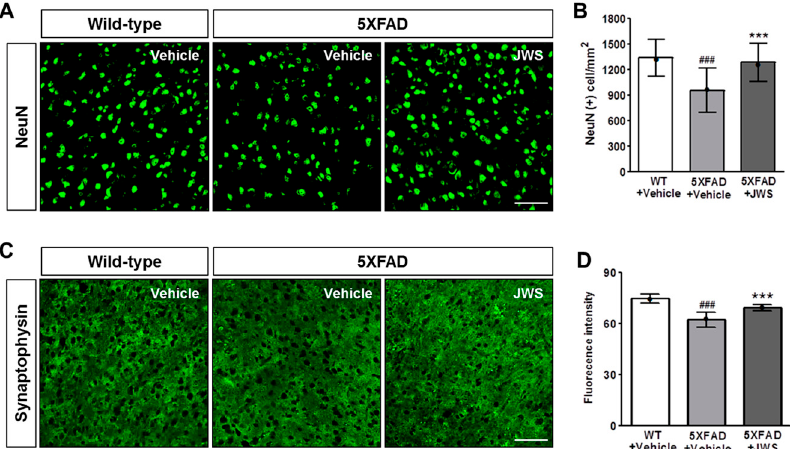
Figure 4. Immunofluorescence evidence of decreased neurodegeneration in the deep cortical layers of the brain in 5XFAD mice. Representative images of brain sections immunostained with anti-NeuN antibody ( A ) and anti-synaptophysin (SYN) antibody ( C ). Scale bar = 100 µ m. Jowiseungchungtang (JWS) significantly reduced the NeuN (+) area ( B ) and SYN (+) area ( D ). Data are presented as mean ± SD ( n = 5 in each group). Significance by Tukey’s post hoc test following one-way ANOVA is indicated as *** p < 0.001 versus 5XFAD + vehicle group and ### p < 0.001 versus WT + vehicle group.